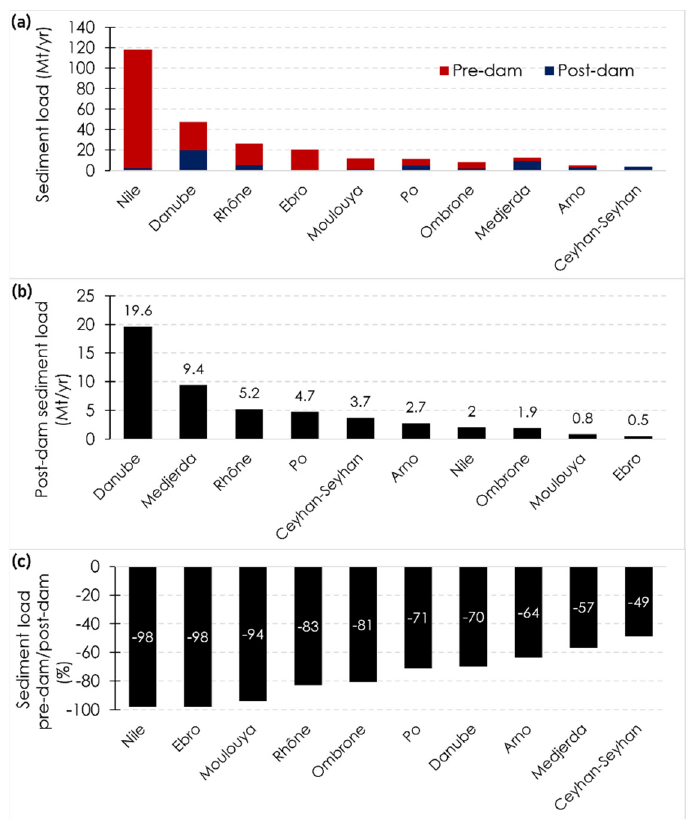
Figure 2. Graphs depicting changing total river sediment flux for the ten deltas in Mt/year ( a ); post-dam (post-1970) sediment flux in Mt/year ( b ); ( c ) percentage loss of sediment flux between pre-dam and post-dam periods. From data collated by [8].